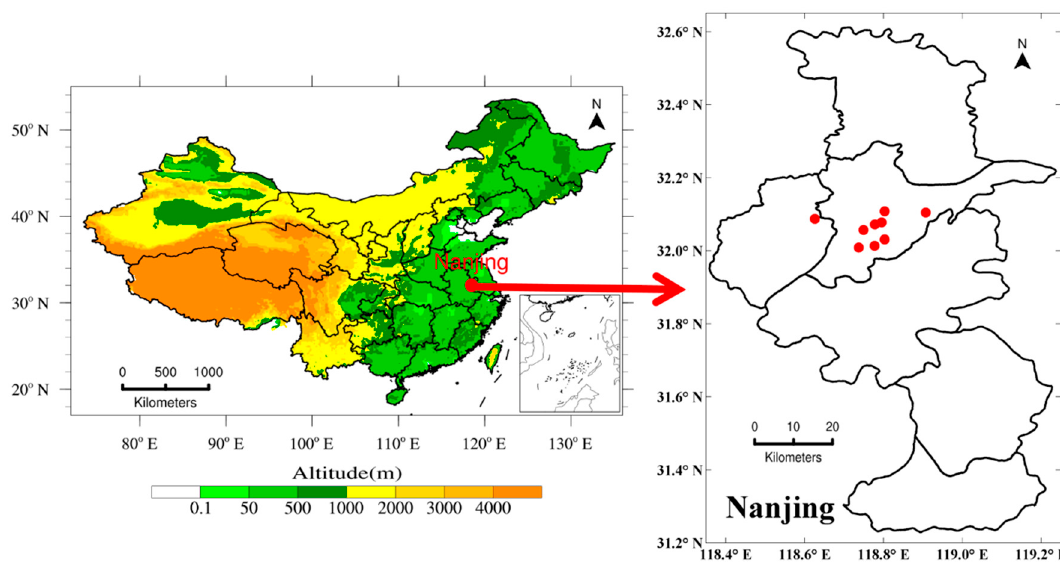
Figure 1. Topographical height (m, a. s. l.) in China with the locations of Nanjing ( left panel ) and nine sites of air quality measurement in Nanjing, an urban area in East China ( right panel ).